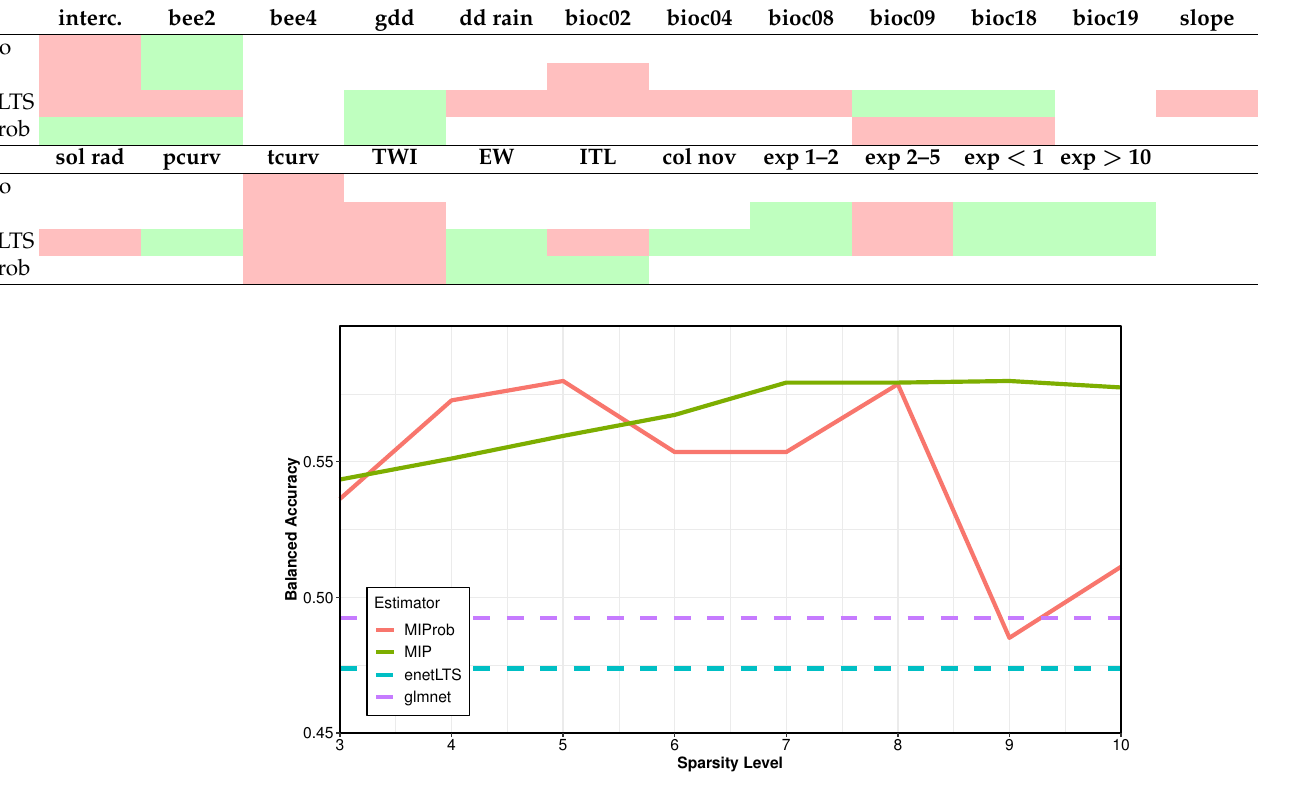
Figure 2. Balanced accuracy computed on a test set encompassing 126 points, as a function of the sparsity level k n for MIP and MIProb (using a 10% trimming for the latter). The average balanced accuracy over 8 repetitions is shown also for Lasso and